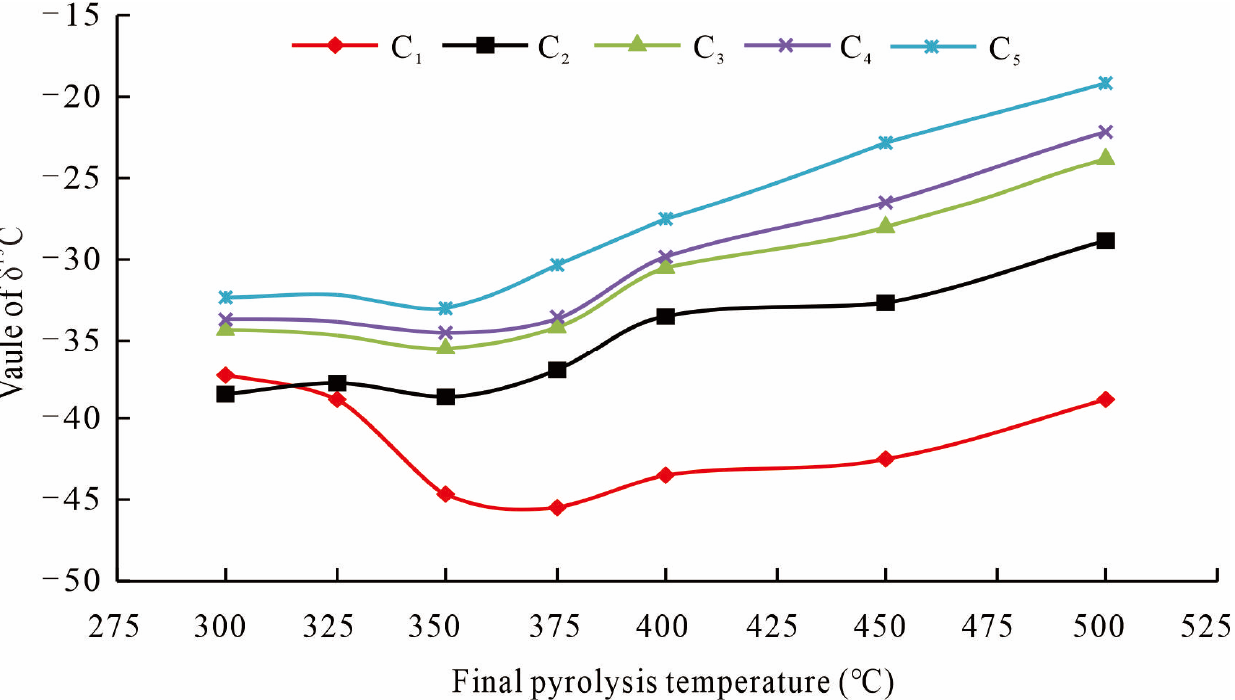
Figure 9. Evolution of carbon isotopic composition of hydrocarbon gases with the increase in the temperature.